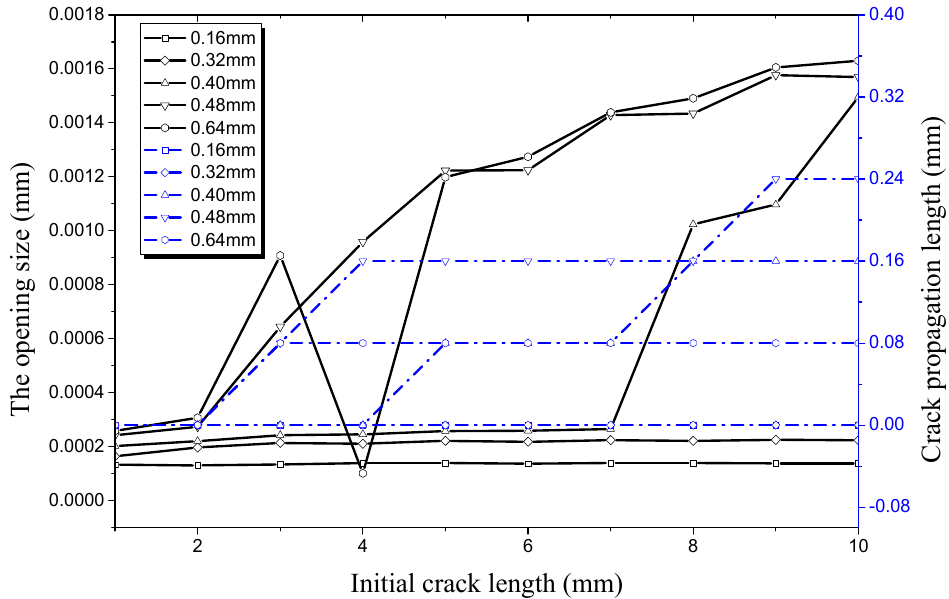
Figure 17. Relationship between radial crack propagation length and initial crack length on the outer surface, and relationship between radial opening size and initial crack length on the outer surface, both under an internal pressure of 21 MPa.